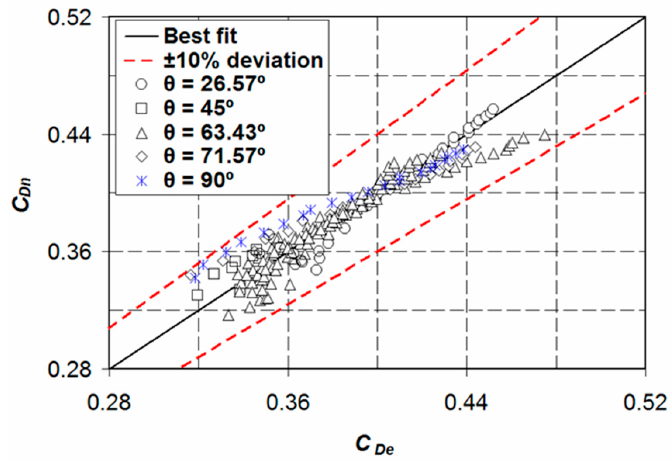
Figure 6. Comparison of predicted and measured discharge coefficients for flows over hydraulically smooth trapezoidal-shaped weirs under free-flow conditions. The downstream-face slope varies from 9.46° to 90°.